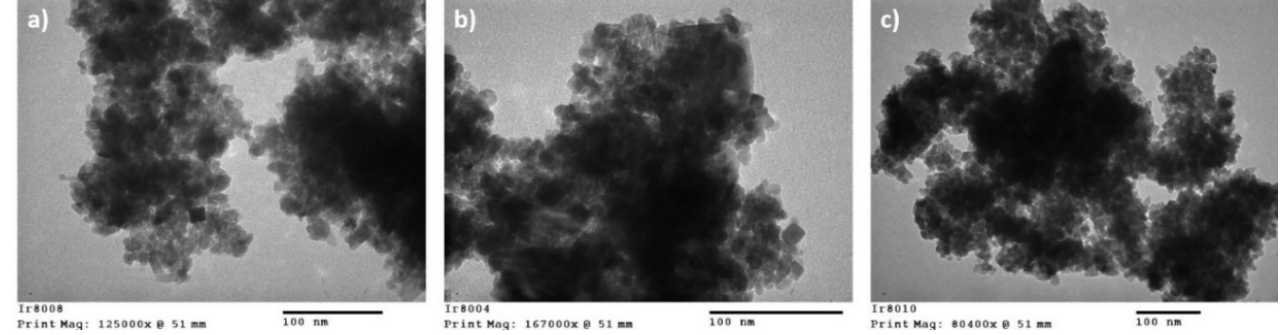
Figure 3. X-ray diffraction patterns of Ir-doped TiO (cid:2870) photocatalysts with different Ir-doped ratios of 0.5 mol%, 1.0 mol%, and 1.5 mol% respectively.